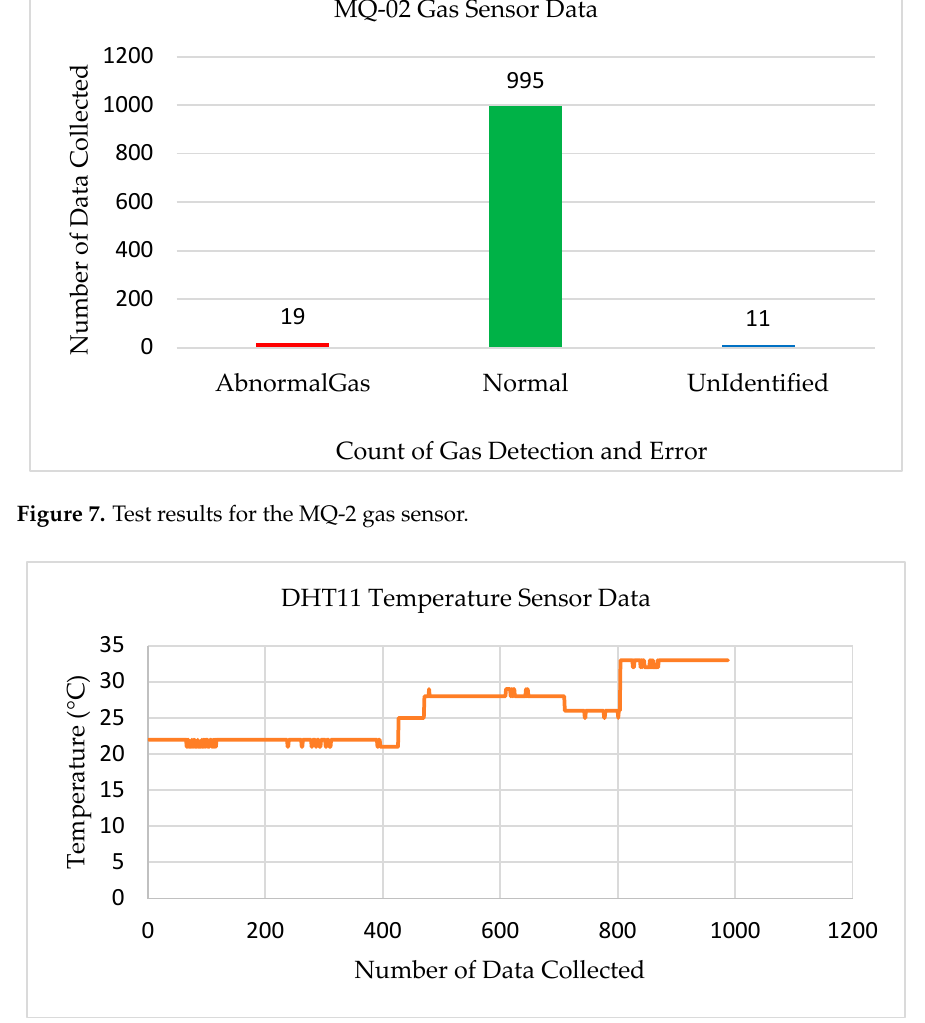
Figure 8. Test results for the DHT11 temperature sensor.